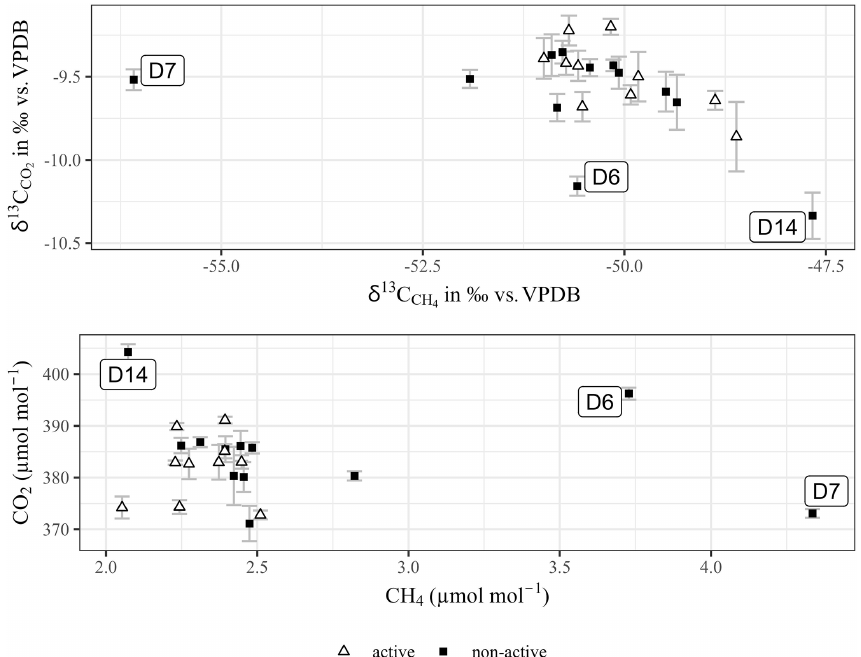
Figure 4. Results for CO 2 and CH 4 molar ratios and δ 13 C values obtained from samples taken above an active (in operation) and non-active (in stand-by) landfill gas suction system unit. Error bars of CO 2 were obtained by measurement triplicates ( n =